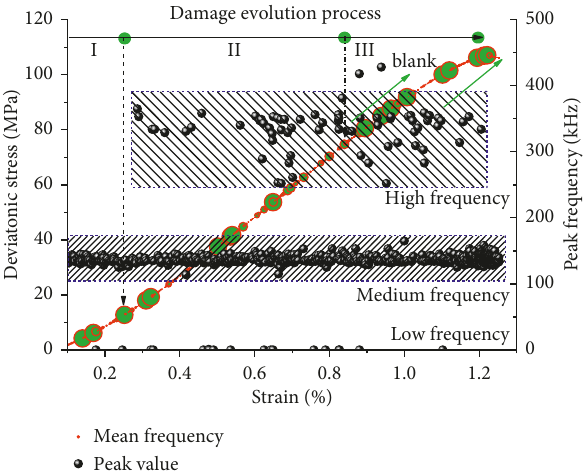
Figure 14: Damage evolution of peak frequency and average frequency by sz-22.